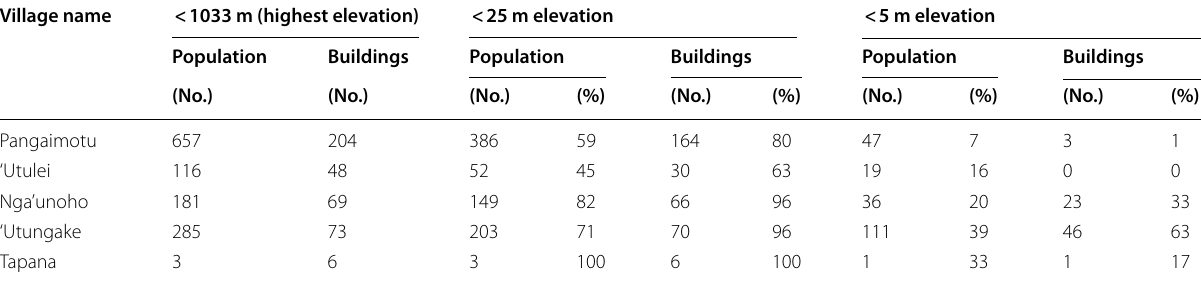
Table 3 Example of number of inhabitants and buildings by village, estimated for different coastal belt widths Village name